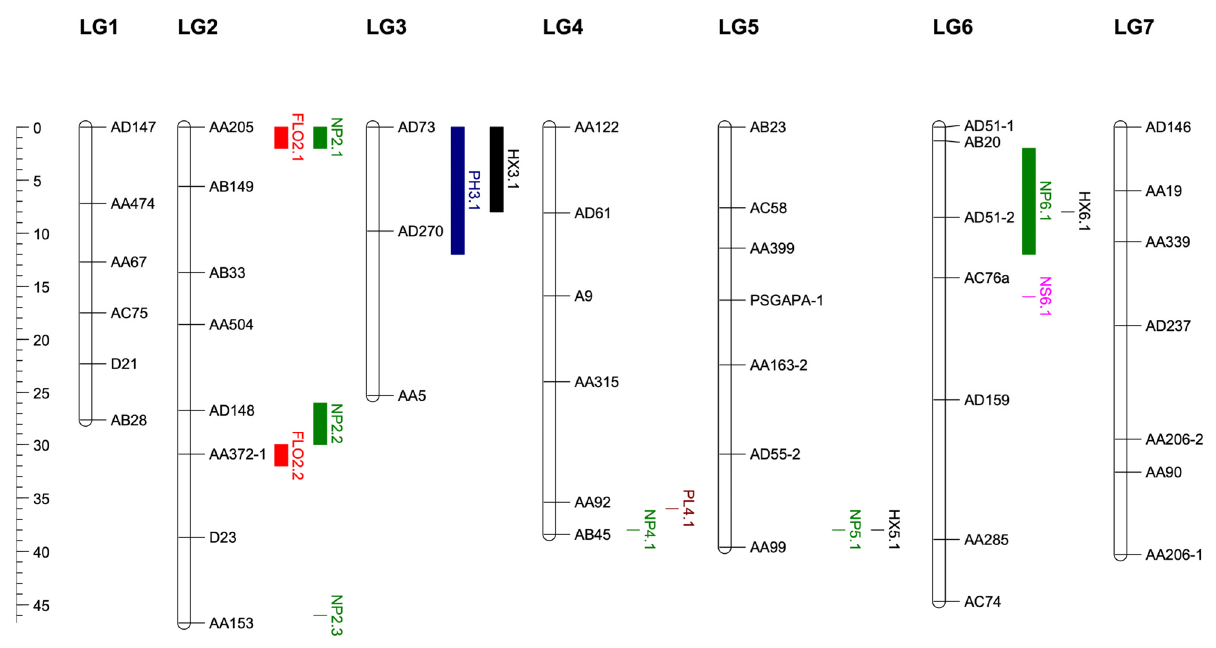
Figure 3. QTLs mapping for FLO: days to flowering, PH: plant height, NP: number of pods per plant, NS: number of seeds per pod, PL: pod length, HX: harvest index in 114 RILs developed from interspecific crosses between P. sativum and P. fulvum.